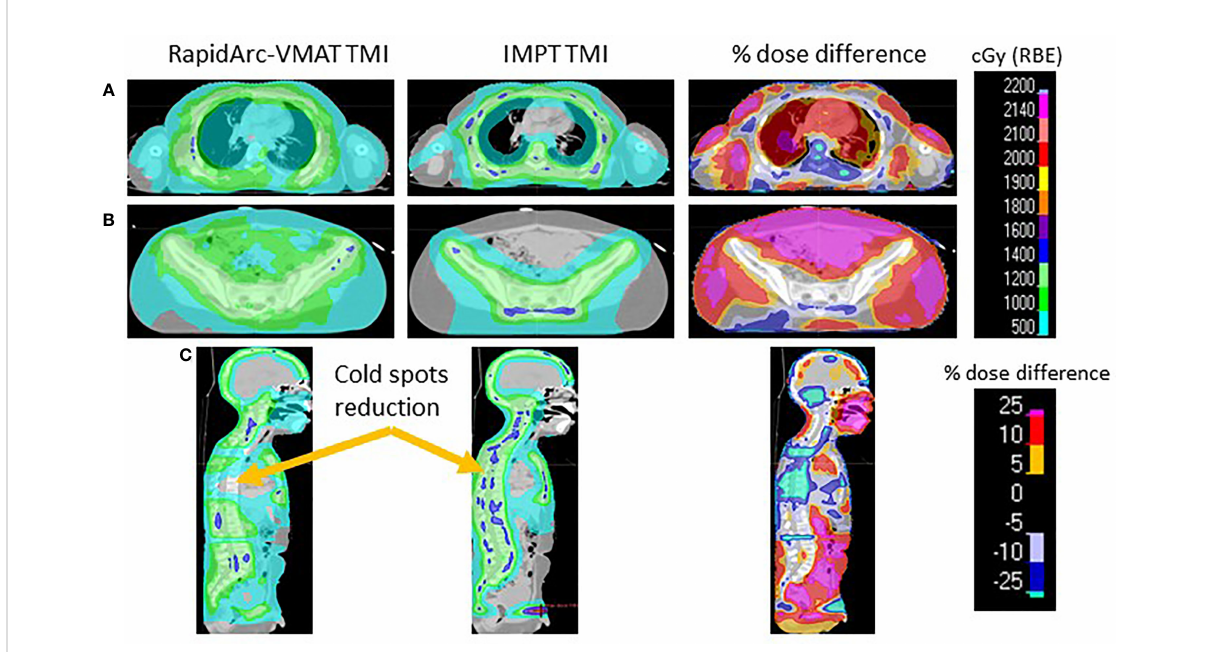
FIGURE 2 (A) Comparing the VMAT, IMPT, and percentage dose difference of the thoracic cavity. (B) Pelvis region comparing TMI plans. (C) Sagittal view demonstrating the cold spots present in VMAT-TMI. VMAT, volumetric modulated arc therapy; IMPT, intensity-modulated spot-scanning proton therapy; TMI, total marrow